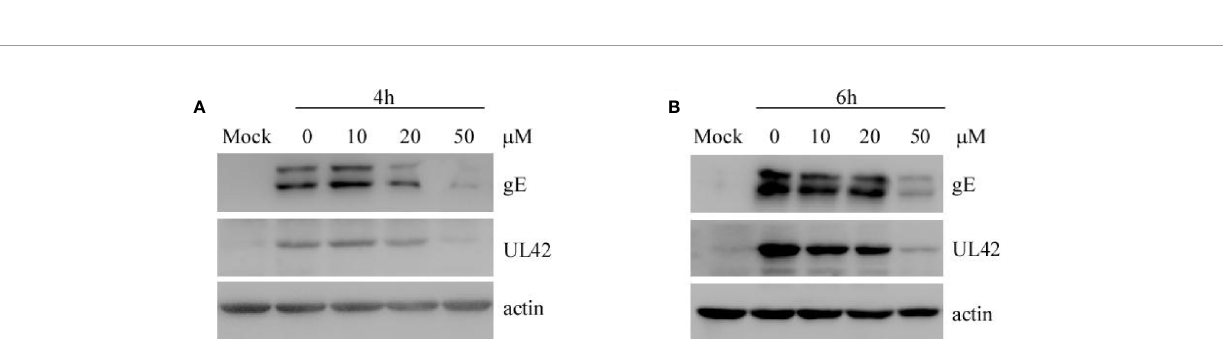
FIGURE 6 | ( – )-Epigallocatechin-3-gallate (EGCG) inhibited pseudorabies virus (PRV) replication in PK15 B6 cells. (A, B) PK15 B6 cells were infected with PRV XJ5 (MOI=0.1) at 37°C for 1 h, then infected cells were incubated with 10, 20, or 50 m M EGCG until harvest. At 4 and 6 hpi, cells were collected to detect the expression of PRV-gE, UL42, and b -actin protein by Western